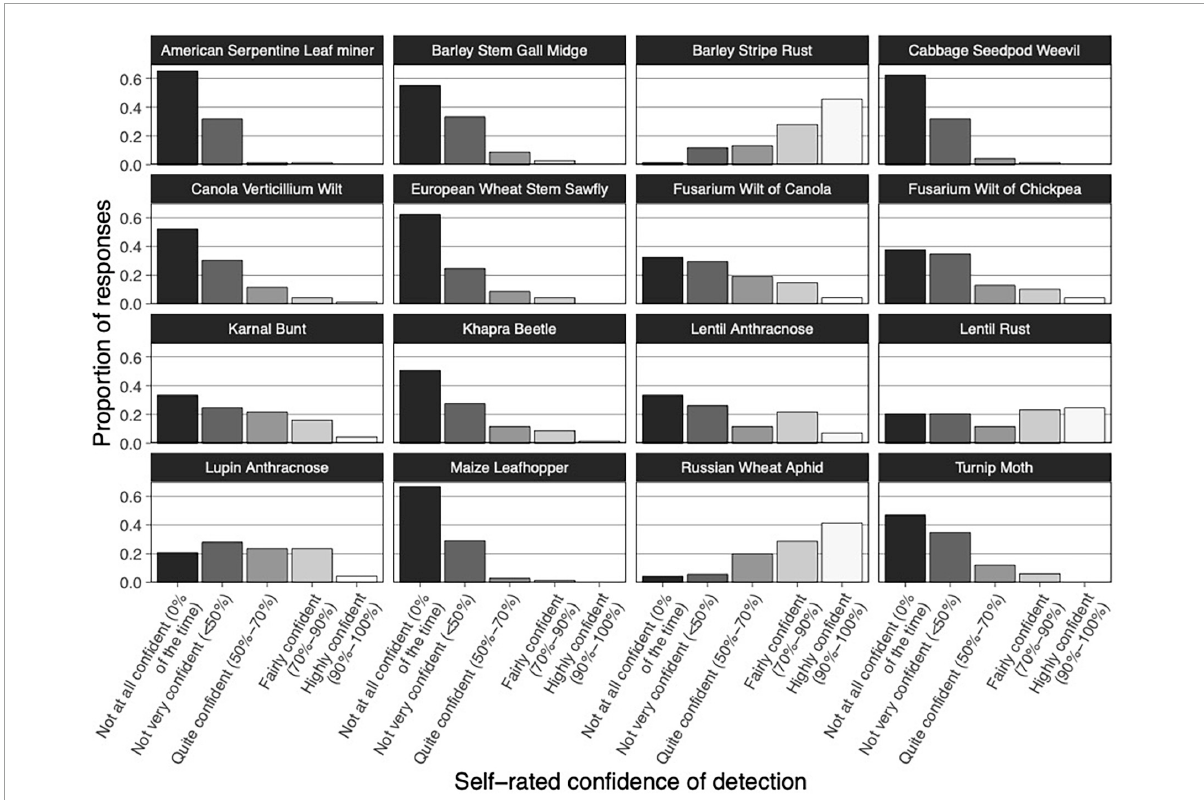
FIGURE3 Crop Safe agronomists’ self-rated confidence of detection of exotic pests and diseases at visual inspection. Vertical bars represent the proportion of responses. Bar gray scaling indicates differences in self-rated confidence of detection, ranging from “not at all confident” to “highly